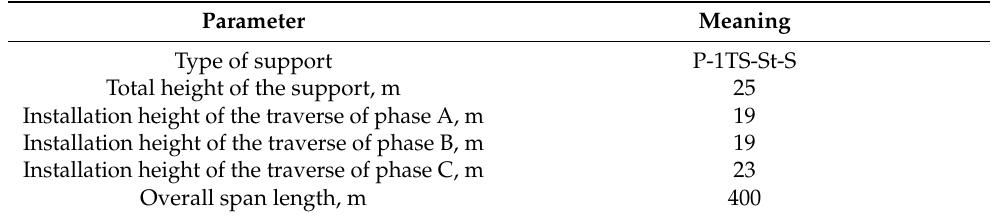
Table 8. Geometric dimensions of the line.